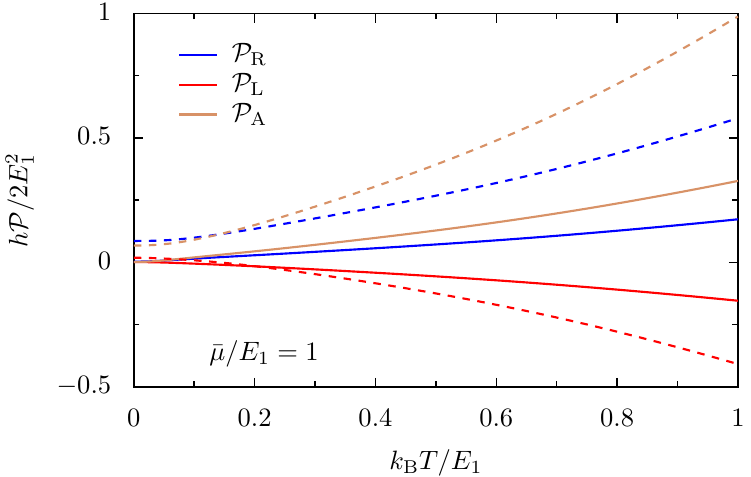
Figure 4: Dissipated power on the right (blue), on the left (red), and the P R P L asymmetry (ocher) as a function of the temperature, for a mean electrochemical P A = 1 situated in the first conductance step. Solid and dashed lines potential of ¯ µ/ E 1 = 0.2 and 0.6, are for voltages of eV / E 1